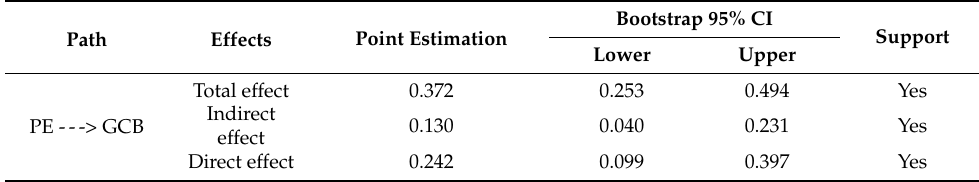
Table 5. Results of the mediating effect test.